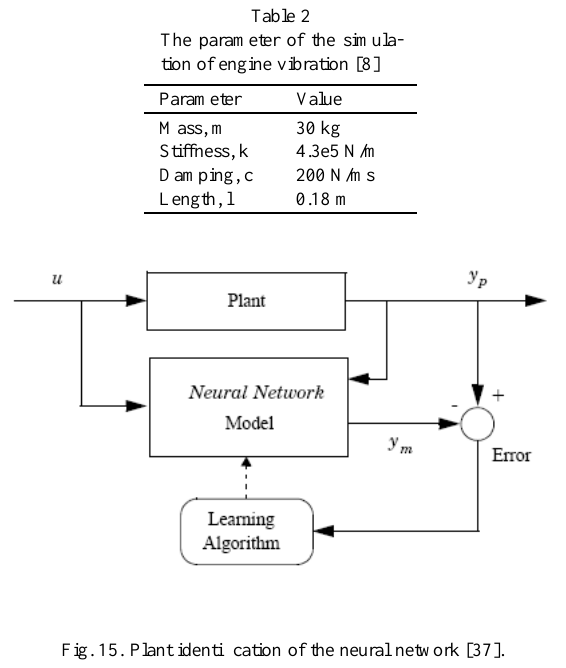
Fig. 15. Plant identification of the neural network